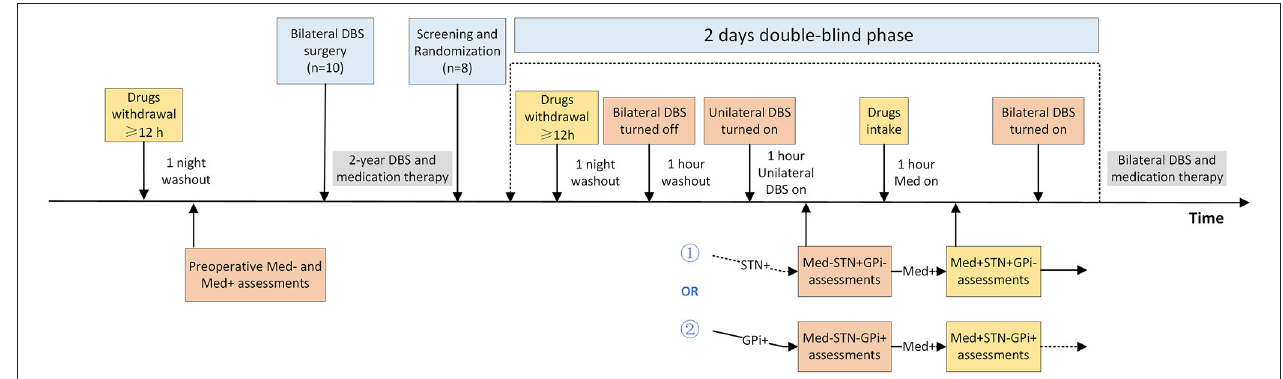
FIGURE 1 | Randomized, double-blind, crossover design of the study. This study involved two time periods, before and 2 to 3 years after surgery. Some patients ( n = 10) were assessed for motor symptoms in Med– and Med + states preoperatively and underwent asymmetric target (unilateral STN, contralateral GPi) DBS treatment. After parameter optimization, the patients were treated with medication and bilateral DBS. We recruited and screened patients 2 to 3 years after surgery ( n = 8) and randomized them into two groups. One group of patients was evaluated first in the STN + GPi– state and then the next day in the STN–GPi + state; the other group was the opposite, STN–GPi + then STN + GPi–. Patients stopped intaking antiparkinsonian drugs the night before the assessment, ensuring that they were off medication for more than 12h. Bilateral DBS was turned off and washed out for 1h before assessment. Afterwards, the unilateral DBS was turned on and motor symptoms were assessed in the Med– condition. Following the Med– condition assessment, the patient took the medication and was assessed 1h later in the Med + condition. After completion of the first day’s assessment, the patient’s bilateral DBS was turned on, although medication withdrawal continued for more than 12h. Assessment of the contralateral DBS on state was performed on the second day. Patients were blinded for all assessment procedures and resumed prior bilateral DBS and medication treatment after the four-state assessments. DBS, deep brain stimulation; GPi, globus pallidus interna; STN, subthalamic